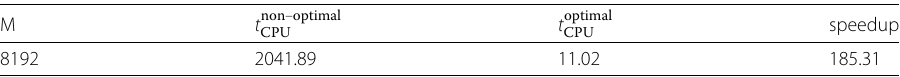
Table 3 Preliminary results with N = 256, K y = K z = 3 for Example 1